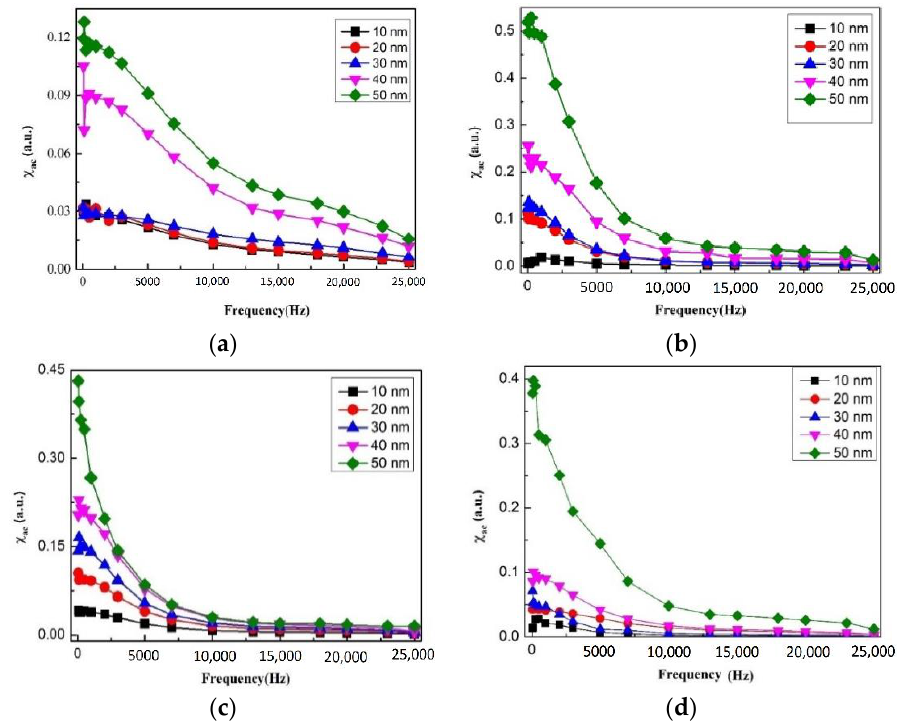
Figure 6. The low-frequency alternate-current magnetic susceptibility ( χ ac ) as a function of the frequency from 10 to 25,000 Hz for samples with thicknesses from 10 to 50 nm. ( a ) RT, ( b ) annealed at 300 °C, ( c ) annealed at 350 °C, ( d ) annealed at 400 °C.